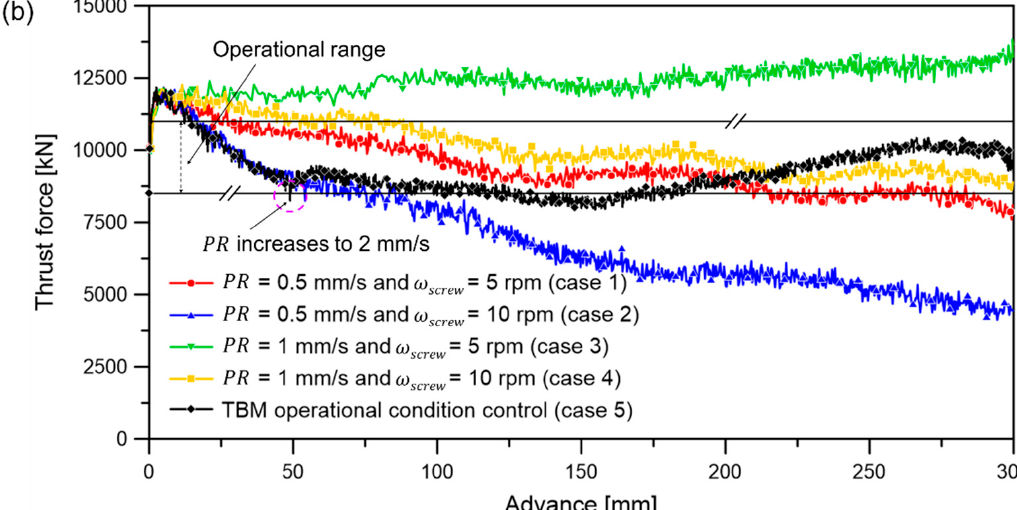
Figure 10. Measured torque and thrust force data during EPB shield tunnelling simulation: ( a ) torque; ( b ) thrust force.